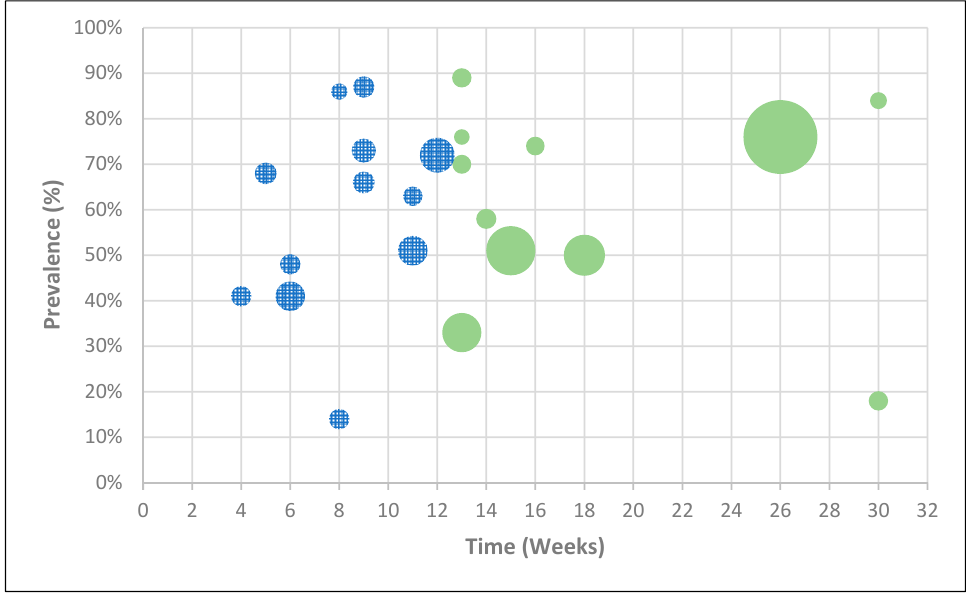
Figure 2. Bubble chart of the reported prevalences of the two long COVID phases (ongoing symp- tomatic COVID-19 in blue; post-COVID-19 syndrome in green), where the size of each bubble is proportional to the study sample size.